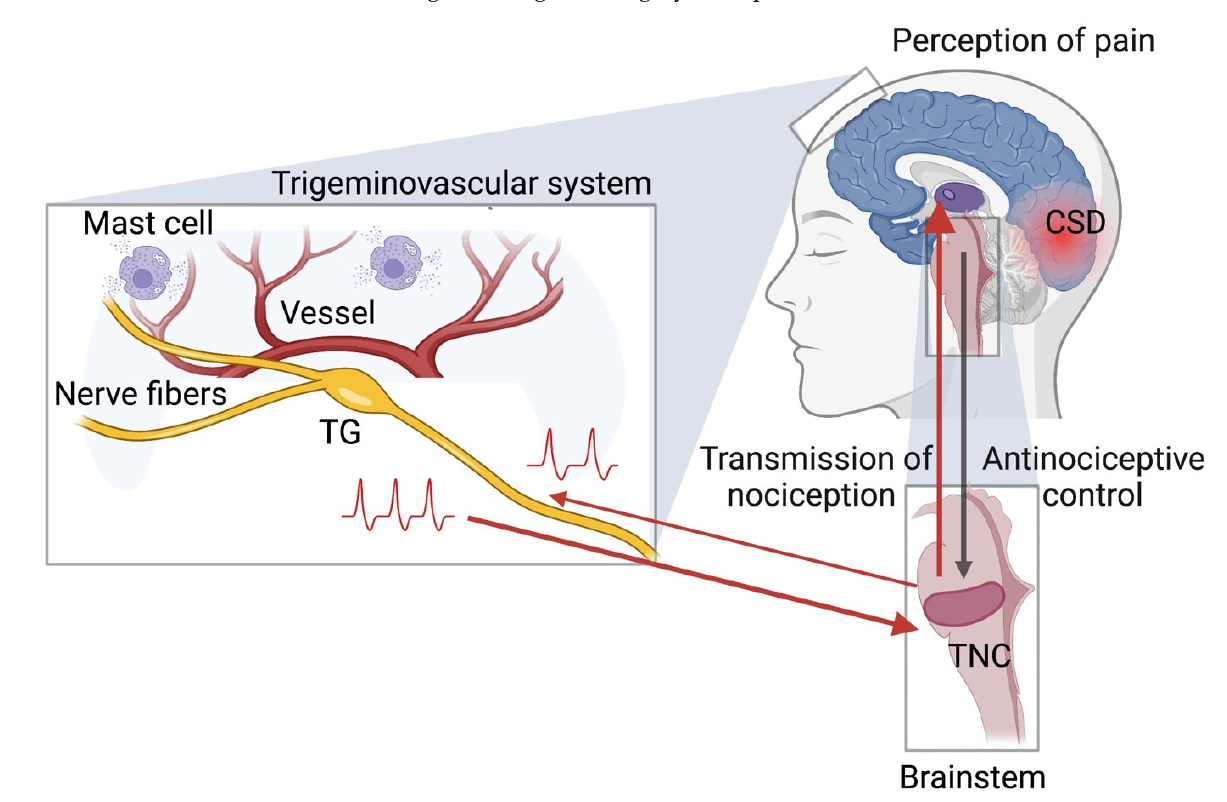
Figure 1. Migraine pain origin, transmission and perception. Migraine related nociceptive signalling originates in the trigeminovascular system (TGVS) composed of the trigeminal ganglia (TG), nociceptive A δ - and C-fibres projecting to meninges, dural mast cells and the local vasculature. These structures can interact with each other via chemical or mechanical communications forming a vicious circle, which promotes and supports neuroinflammation, activation and sensitization of nociceptors. Nociceptive signalling (red arrows) can be initiated by mechanical forces, from pulsating dural vessels, CSD- or stress-induced degranulation of mast cells or by antidromic spiking directed to the meninges and associated with the release of several neuropeptides including CGRP. Migraine-related nociceptive signalling is transmitted from the meninges through the brainstem (zoomed down in grey box) trigeminal nucleus caudalis (TNC) and thalamus (purple), to the higher pain centres in the cortex performing the function of pain perception. Opposite to the ascending nociceptive signalling, the descending inhibitory control of the brainstem provides the anti-nociceptive function (dark grey arrow). A migraine attack can start with cortical spreading depression (CSD), a phenomenon typical for migraine with aura with massive depolarization of neurons and glial cells slowly propagating along the cortex.